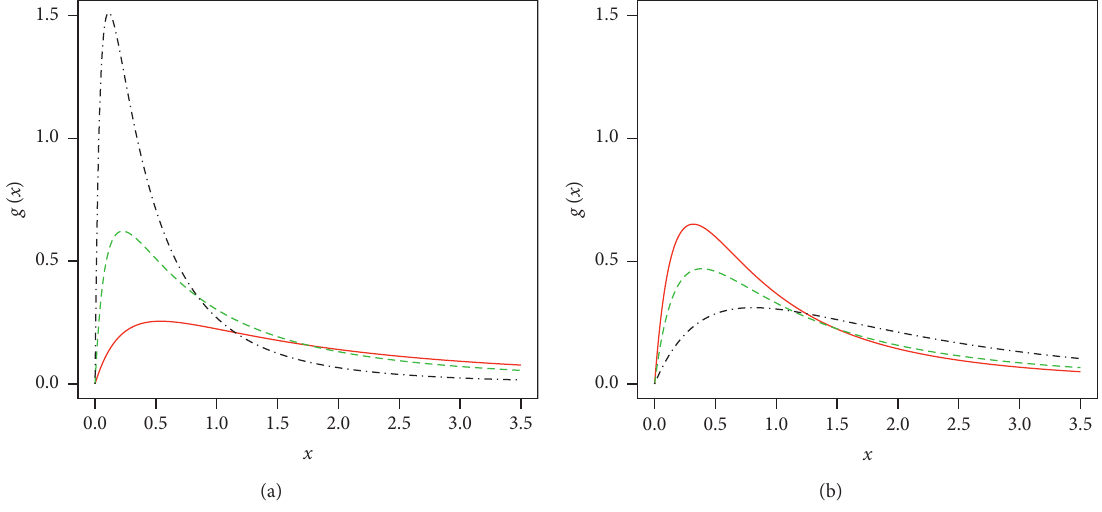
Figure 1: Plots for the pdf of the L-Claim distribution for selected parameter